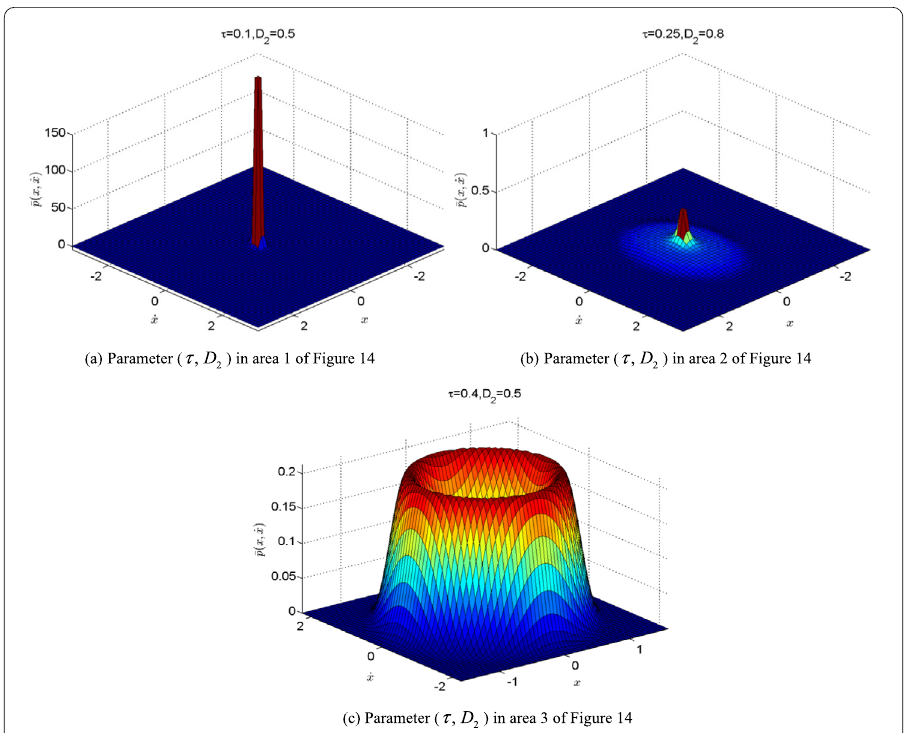
Figure 16 Joint PDFs for ¯ p ( x , ˙ x ) under multiplicative noise excitation (taking τ and D 2 as unfolding